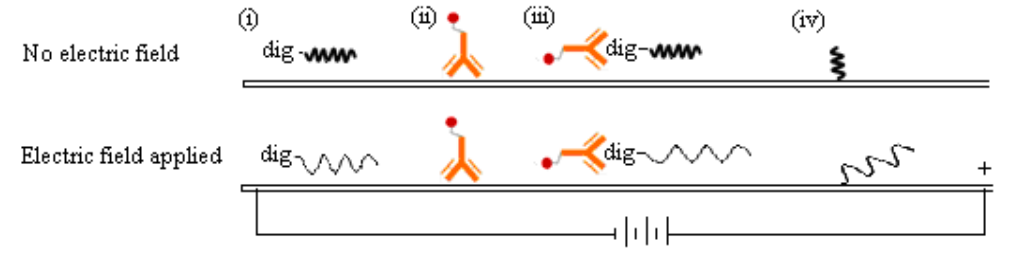
Figure 7. Schematic of configuration variation of single-stranded DNA’s on the electric-induced MBLF strips: (top) no electric field; (bottom) DNA molecules are stretched